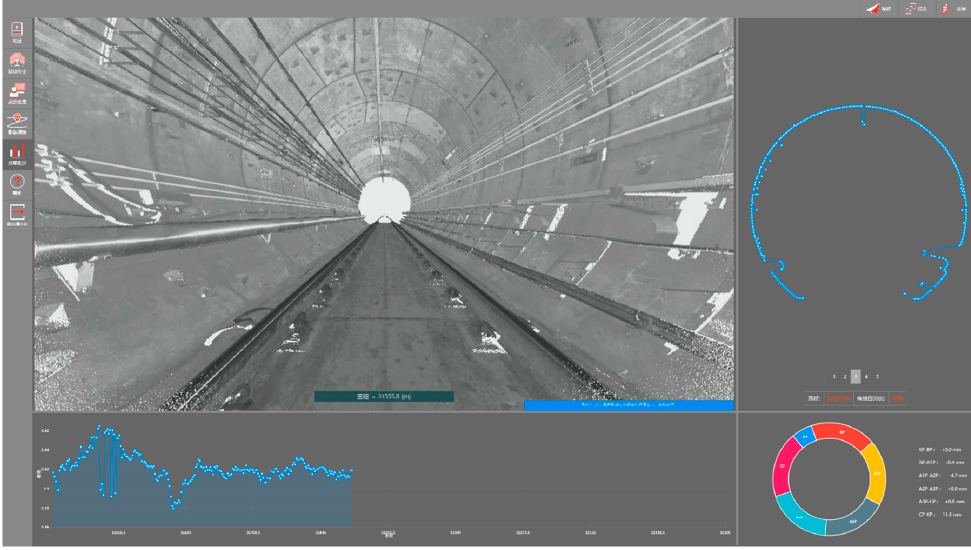
Figure 14. Results display interface.